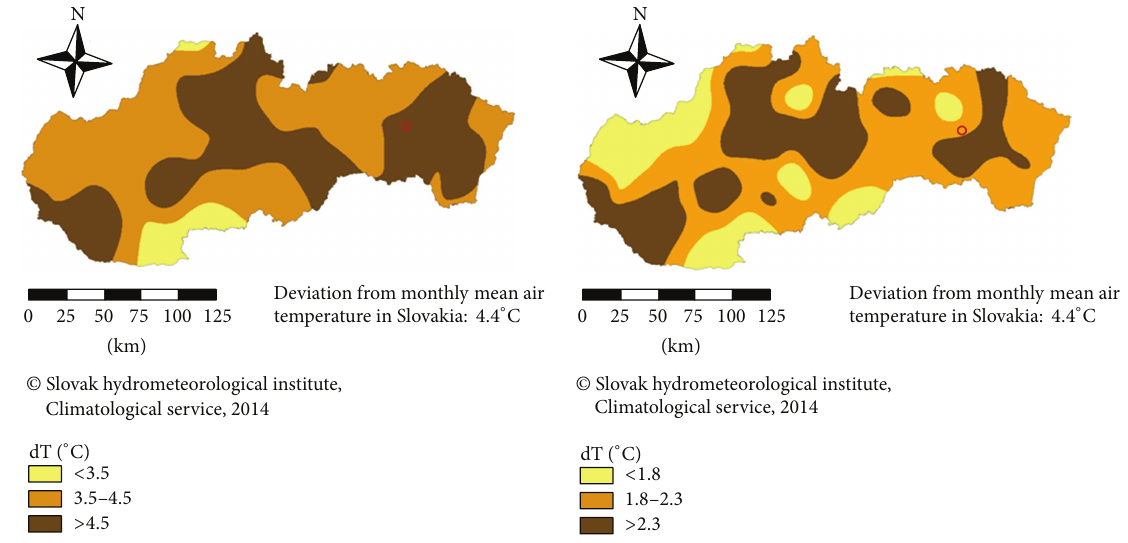
Figure 16: Deviations of the average monthly air temperatures from the normal in March/April 2014 [42] (according to the Slovak Hydrometeorological